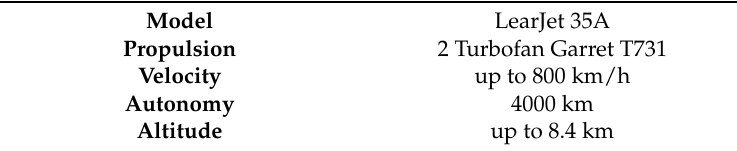
Table 1. Airplane parameters.